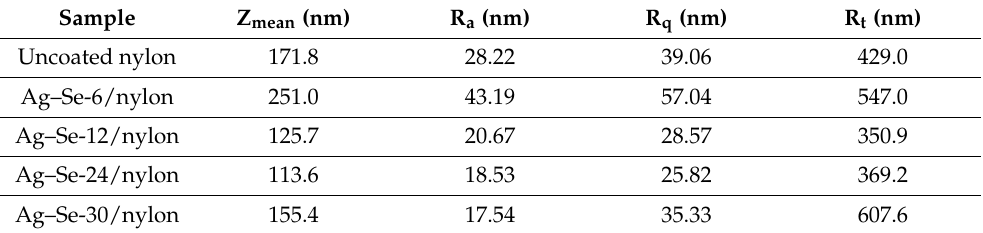
Table 7. Surface topographical parameters average height (Z mean ), average roughness (R a ), root- mean-square surface roughness (R q ), and peak-to-valley roughness (R t ) obtained by AFM analysis. Sample Z mean (nm) R a (nm) R q (nm) R t (nm) 171.8